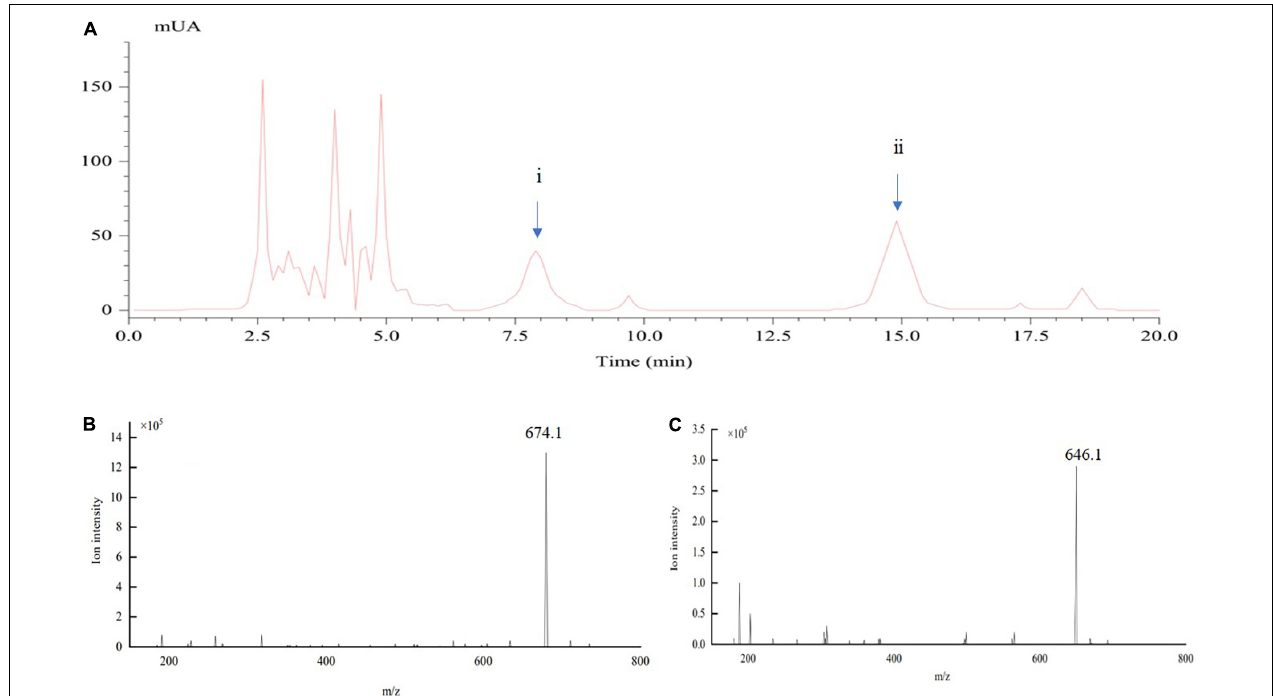
FIGURE 1 | Determination of crude toxin compounds from the liquid culture of mycelia of Ustilaginoidea virens by LC-electrospray ionization (ESI)-MS. (A) represents the spectra of HPLC-UV; (B,C) show the ESI-MS spectra of ustiloxins (A) (peak ii) and (B) (peak i), respectively, appearing in (A) .